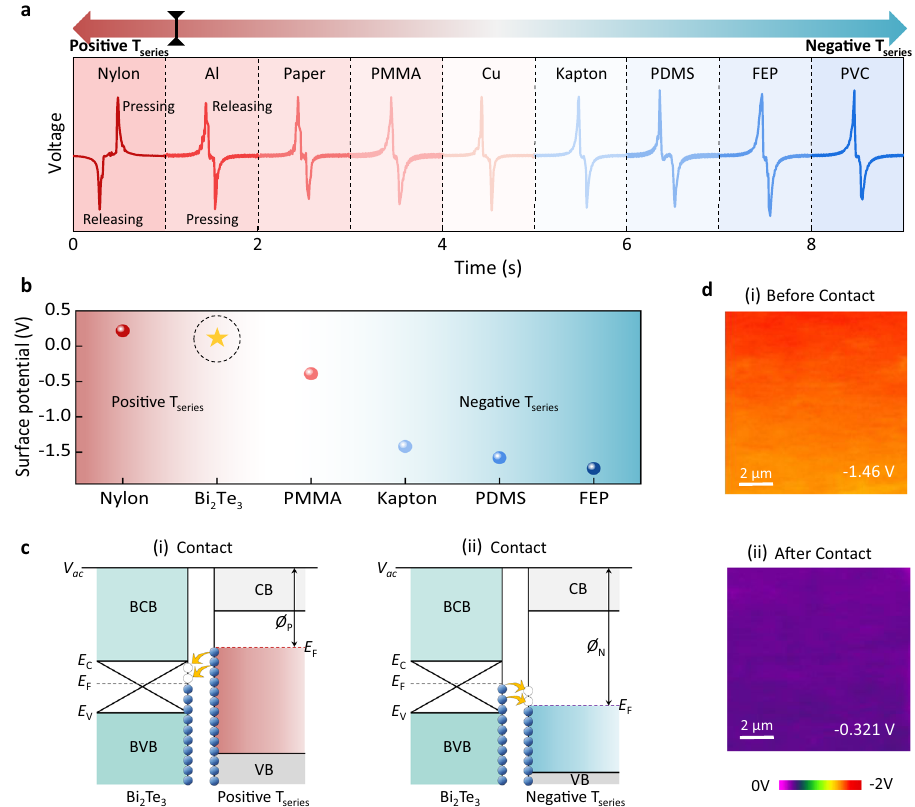
Fig. 3 Triboelectric series positioning of the TI fi lms. a Output signals of the solution-based TI-TENGs with various media as the counter triboelectric layer, which hint at the triboelectric series of TI fi lm between nylon and Al fi lm. Note that the red arrow indicates positively triboelectric (T series ) charging properties and the blue arrow indicates negatively triboelectric charging properties. The black symbol on the arrow proposes the possible position of TI materials. b The measured surface potential of various triboelectric layers using the KPFM technique. The star symbol and the dashed circle denote the Bi 2 Te 3 -NP fi lm. c Energy band diagram for Bi 2 Te 3 -NP fi lm when contacting (i) positively electri fi ed materials and (ii) negatively electri fi ed materials. The crossed symbols indicate the conductive surface state of TI material. E F is the Fermi energy and E c(v) is the bulk conductive (valence) band edge of Bi 2 Te 3 . Ø Ø p and n are the work functions for positive and negative triboelectric materials, respectively. d Surface potential variation of Kapton (i) before and (ii) after contact with Bi 2 Te 3 -NP fi lm. Source data are provided as a Source Data fi